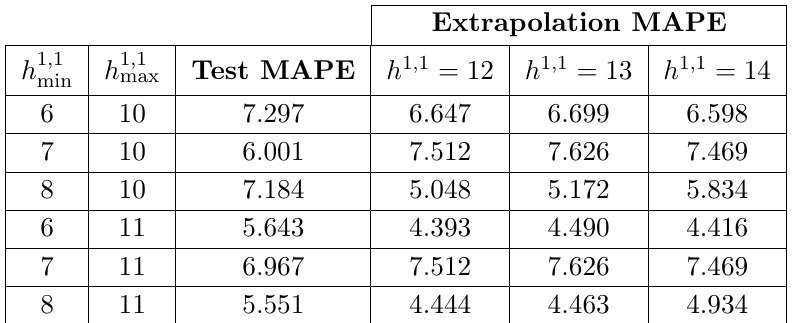
Table 4 . Results of training our model on various h 1 ; 1 ranges. The model with h 1 ; 1 performs well on the test set and the best on extrapolation to higher h 1 ; 1 values.